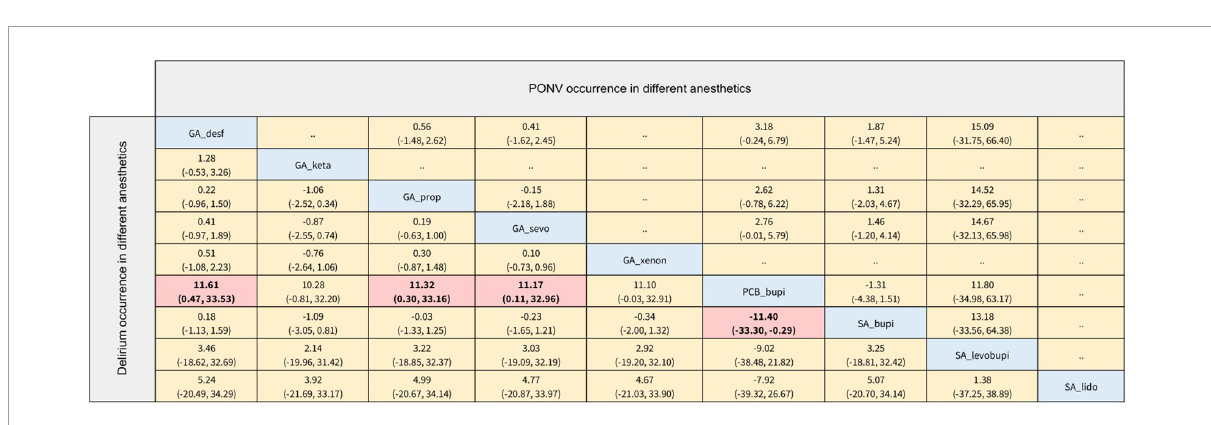
FIGURE5 The league table of delirium and PONV occurrence in different anesthetics (Data are expressed as Log OR,